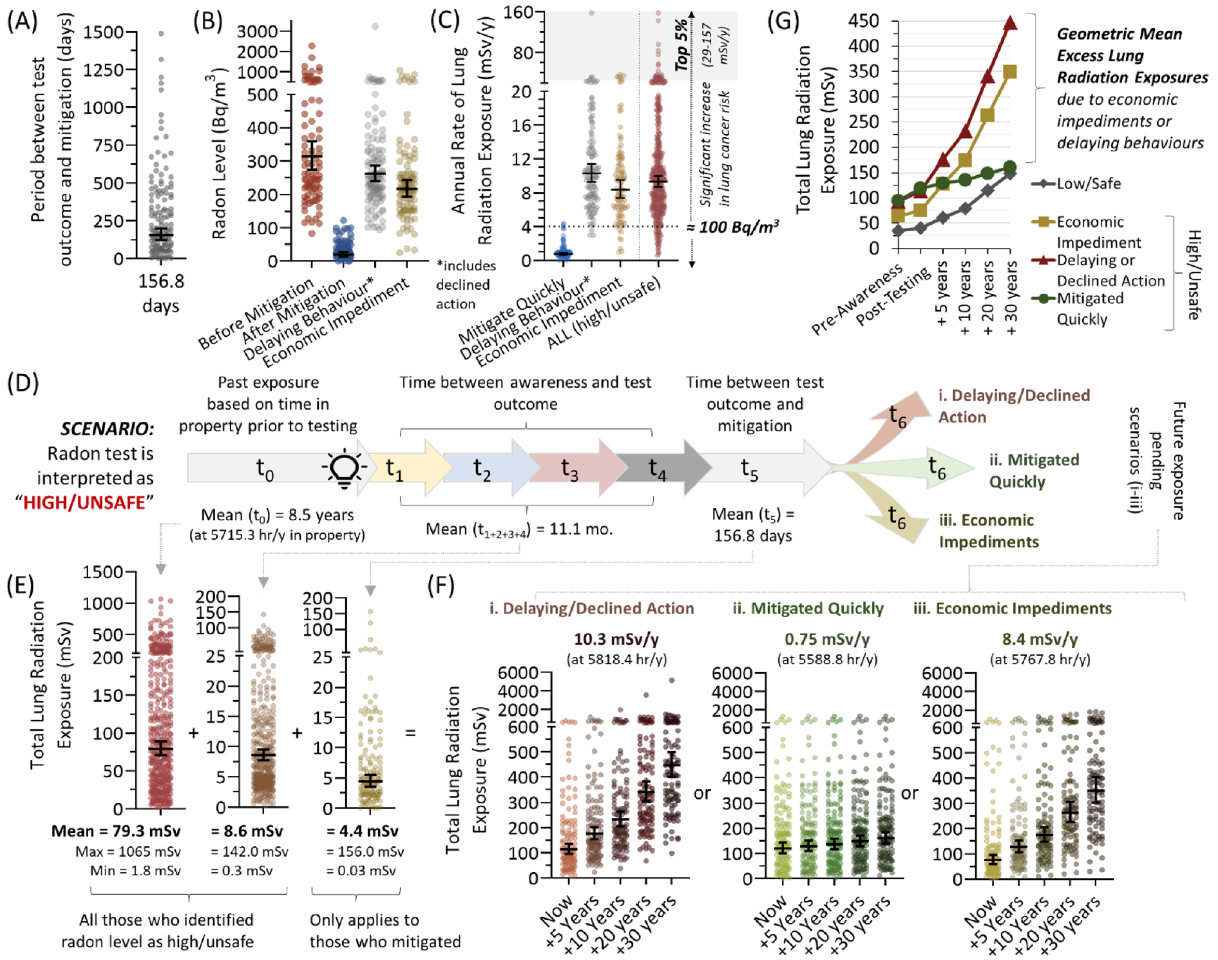
Figure 6. Radiation doses to the lungs of people interpreting their radon as high or unsafe, as a function of radon mitigation behaviour. ( A ) Individual (dots) and geometric mean (line and number) time periods between obtaining a radon test outcome to completion of a radon reduction mitigation, for those who interpreted their primary residential radon test outcome as ‘high/unsafe’ and who obtained a radon mitigation. ( B ) Residential radon levels for the behavioural groups outlined in Fig. 5D,E, including post-mitigation radon levels verified for those who ‘mitigated quickly’ (blue dots). ( C ) Annual rate of lung radiation exposure from radon for the behavioural groups from ( B ). Rates for the ‘mitigated quickly’ group were derived from post-radon mitigation levels. ( D ) A schematic indicating the time periods (t 0 to t 6 ) influencing radon gas exposure in residential properties for which radon levels were interpreted as ‘high or unsafe’ with three potential long-term outcomes depending on radon mitigation behaviour type. t values = geometric means. ( E ) Scatter plots of total lung radiation experienced by individuals who identify their radon levels as ‘high/unsafe’ for indicated exposure periods. Mean values refer to geometric means. ( F ) Based on current (‘now’) total exposures (calculated as the sum of exposures from ( E )), and variable behavioural responses modifying future exposure (i.e., radon reduction or not), a projection of future total doses of radiation to lung from residential radon over a 5–30-year period. ( G ) Line graph of total lung radiation exposure data from ( E ) relative to long term exposure of those interpreting their household radon as ‘low/safe’. Figures were prepared using Excel and GraphPad Prism 9.1.1 (225) (www. graph pad.